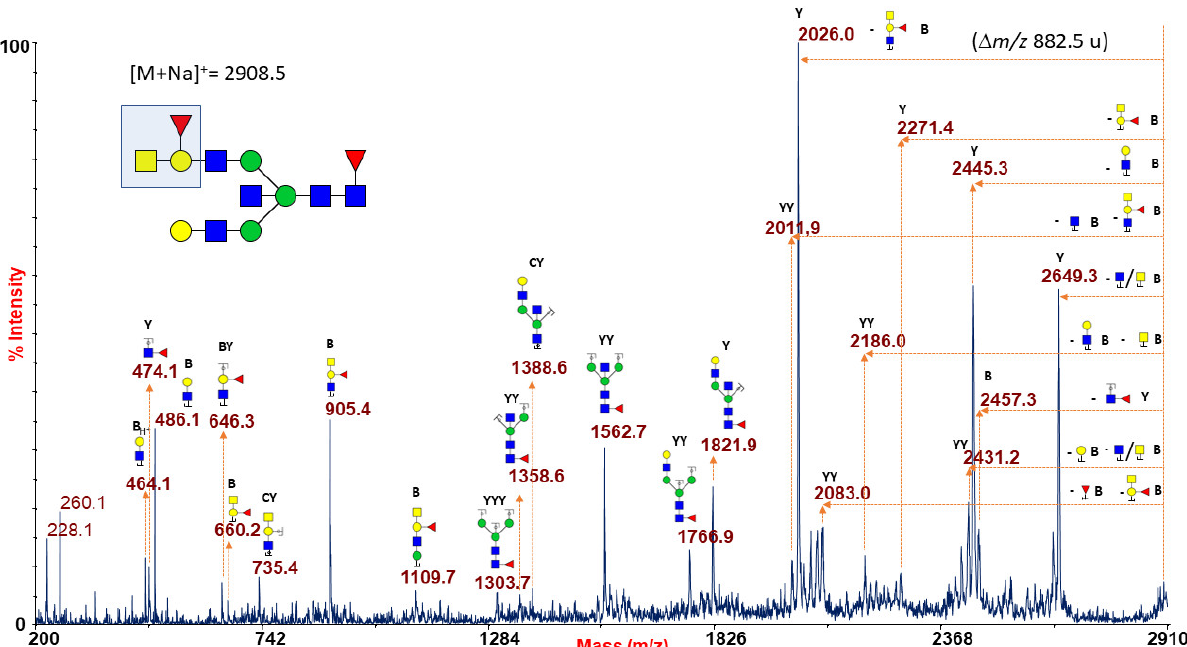
Figure 2. MALDI TOF/TOF MS/MS characterization of the N-glycan precursor at m/z 2908.5 from blood group A human erythrocytes. All the fragmentation pattern points to delineate an N-linked glycan moiety with a terminal blood group A epitope (sketched in the reported structure), as mainly revealed by B-type ions at m/z 660.2, 905.4 and 1109.7, by the predominant Y ion at m/z 2026.0 (m/z 882.5 u from the parent ion), and by a further Y ion at m/z 2271.4. GlcNAc, blue square; Man, green circle; Gal, yellow circle; NeuAc, purple lozenge; Fuc, red triangle.